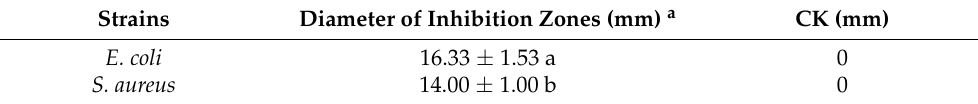
Figure 6. Antimicrobial effect of AgEo on E. coli ( a ) and S. aureus ( b ). Table 2. Antimicrobial effects of AgEo on E. coli and S. aureus (mm diameter zone). Strains